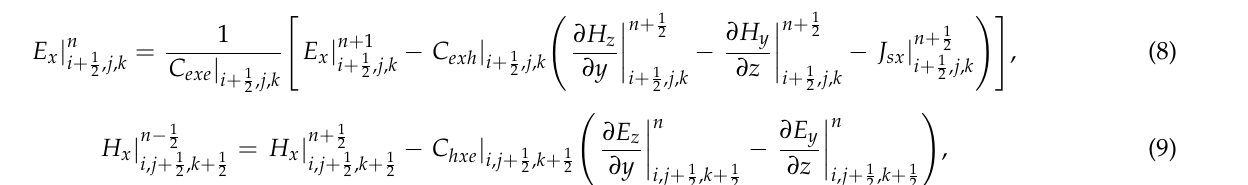
Figure 2. Flow chart on the RTM method.